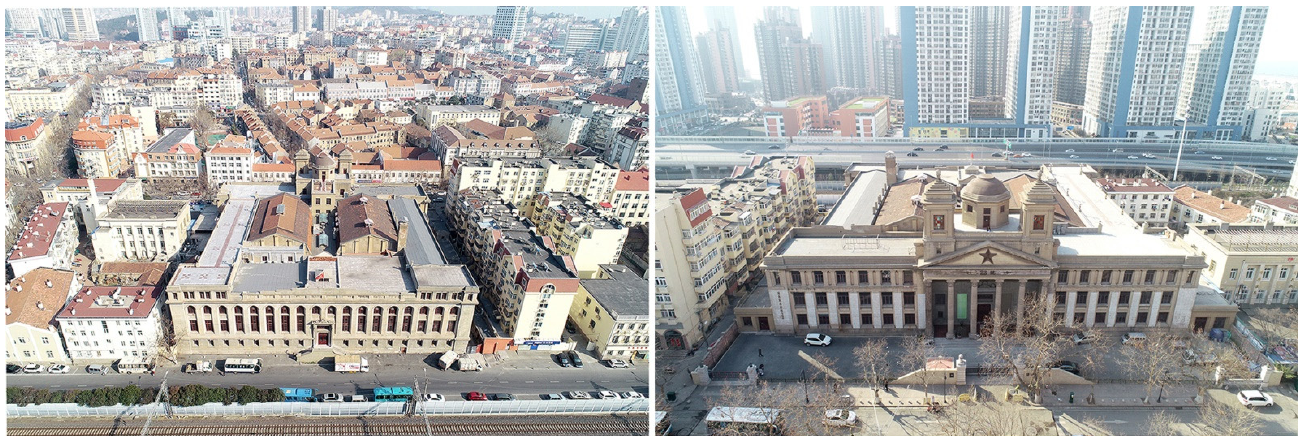
Figure 8. Aerial View of Qingdao Exchange Building.